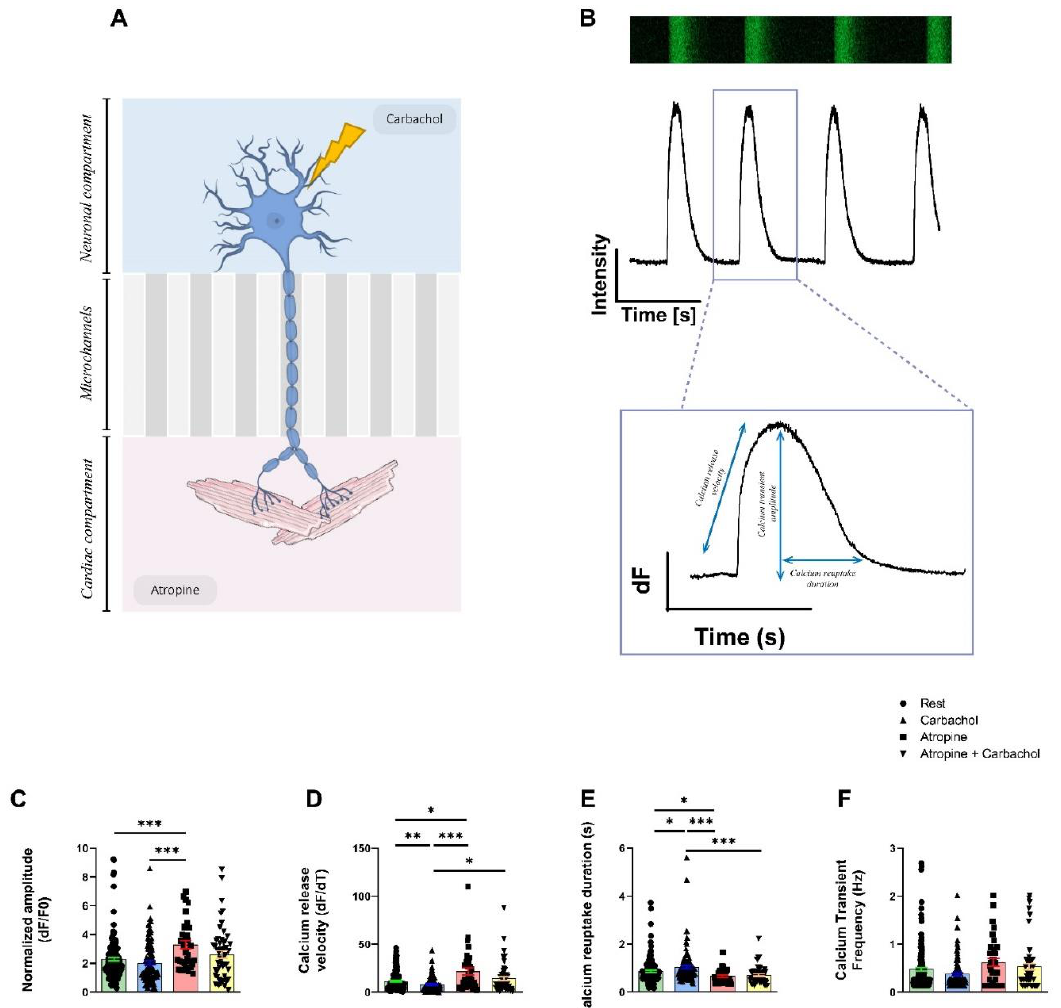
Figure 4. Monitoring of the intracellular calcium cycling properties on 14-day-old neuro–cardiac OOC using PC12 and hiPSC-CMs. ( A ) Schematic representation of neurocardiac OOCs with cellular compartments showing where the different molecules are added. The M2 muscarinic receptor antagonist Atropine is added to the cardiac compartment and the muscarinic receptor agonist carbachol is added to the neuronal compartment. ( B ) CaT are recorded using Fluo4-AM. Representation of CaT in hiPSC-CMs recorded in line-scan configuration with the corresponding plot below from which calcium kinetics are obtained. ( C ) Parameters of normalized amplitude of CaT, ( D ) calcium release velocity, ( E ) duration of Ca 2+ reuptake and ( F ) frequency of CaT are presented in resting condition, after addition of 1.5 mM Carbachol and or 1 µM Atropine on the cardiomyocytes located in the cardiac compartment after 14 days of co-culture. Data are presented as mean ± SEM, Rest n = 145, Carbachol n = 108, Atropine n = 34, Carbachol + Atropine n = 55. Dunn’s multiple comparisons test were performed, * p < 0.05, ** p < 0.01, *** p < 0.001. Release of the neurotransmitter after the stimulation of PC12 cells by Carbachol in neuronal compartment affects the Ca 2+ kinetics in cardiomyocytes (Figure 4D–F). The CaT frequency (Rest: 0.48 ± 0.04 Hz, Carbachol: 0.38 ± 0.03 Hz, Atropine: 0.63 ± 0.09 Hz, Atropine + Carbachol: 0.53 ± 0.07 Hz, p = ns) was not affected by the different experimental conditions in cardiomyocytes (Figure 4F). The addition of Carbachol did not modulate the CaT amplitude (Rest: 2.28 ± 0.13, Carbachol: 2.03 ± 0.14, p = ns, Figure 4C) but affected Ca 2+ release velocity after PC12 stimulation (Rest: 11.41 ± 0.86, Carbachol: 7.76 ±